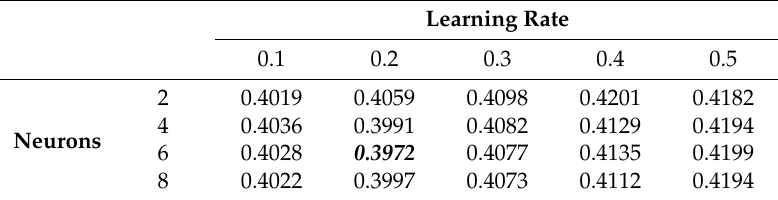
Table A6. Sensitivity of multilayer perceptron (MLP) to the number of neurons in the hidden layer and the choice of the learning rate for the back-propagation training algorithm, the average over three runs.